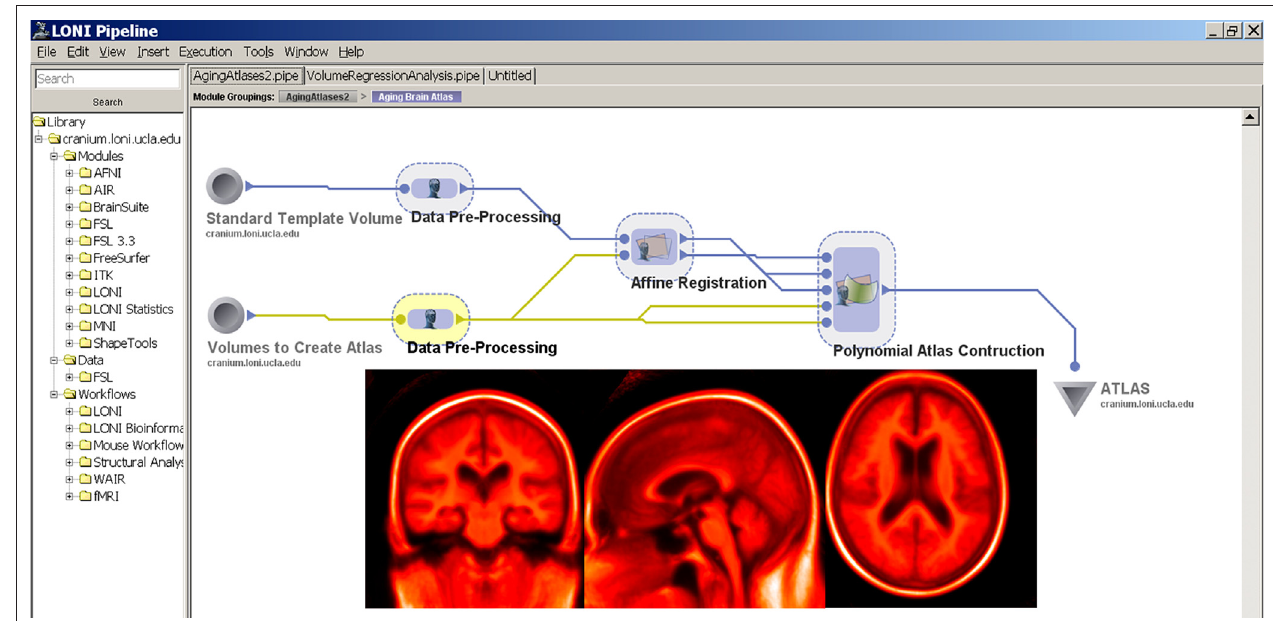
FIGURE 3 | LONI Pipeline workfl ow for constructing a population-based whole brain anatomical atlas in Alzheimer’s Disease patients (insets).